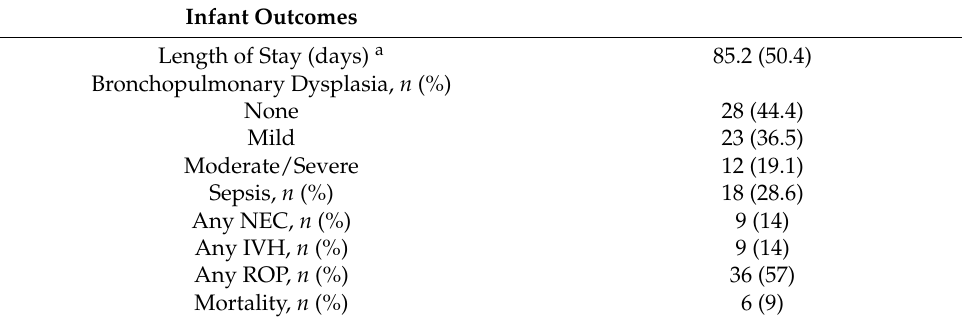
Table 2. Selected morbidities of study population ( n =